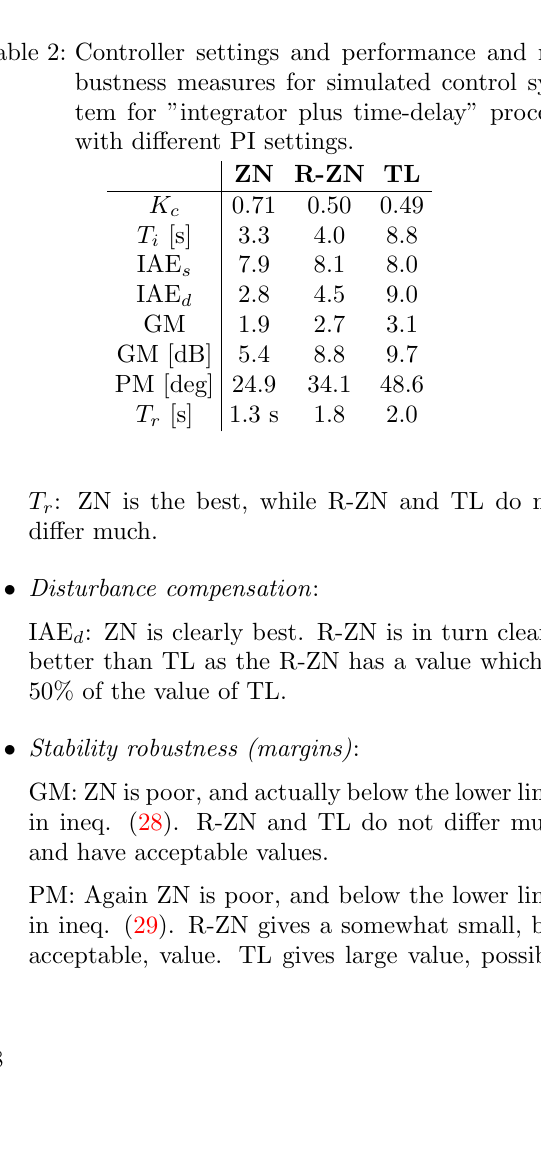
Figure 3: Responses with various PI settings.